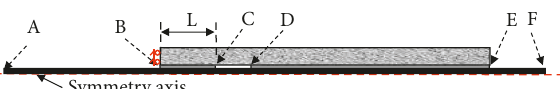
Figure 9: The axisymmetric model of grouted rock bolt systems with one bond